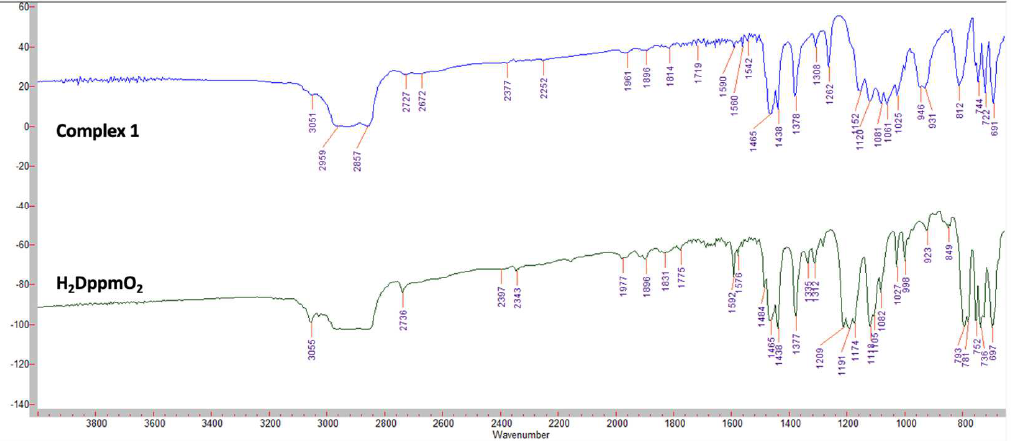
Figure 1. The infrared spectrum of complex [Yb(HdppmO 2 ) 3 ] 1 ( top ) and free ligand H 2 dppmO 2 ( below ) in Nujol mull.